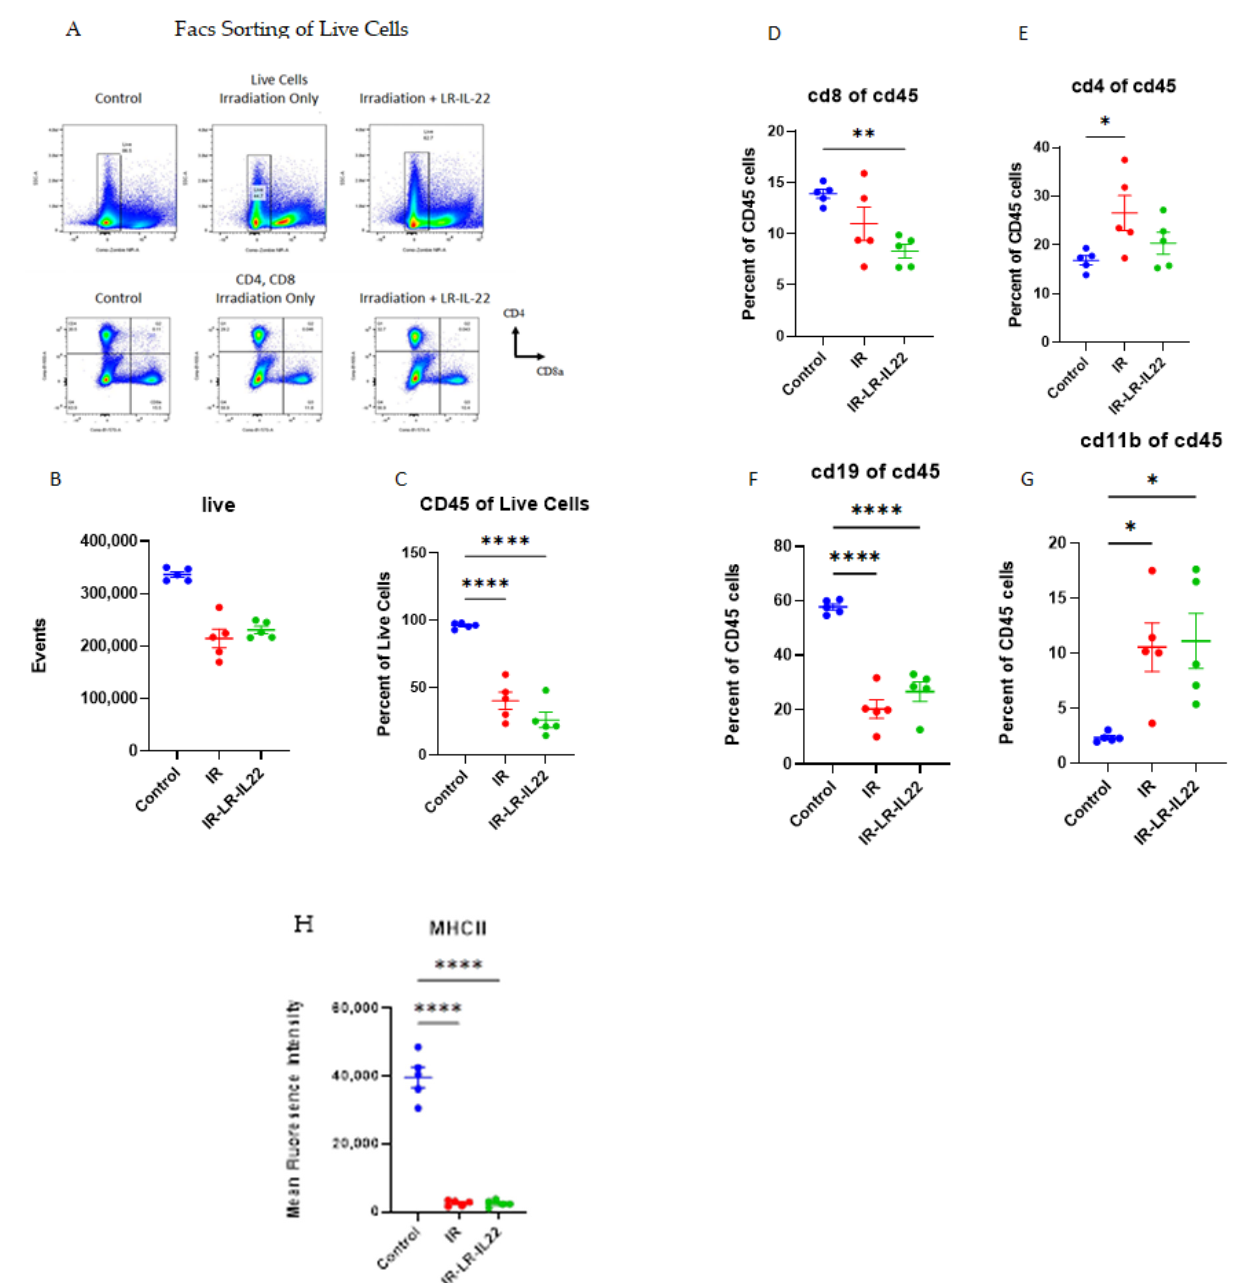
Figure 6. Effect of LR-IL-22 on composition of splenic immunocytes at 21 days after TBI. C57BL/6NTac female mice were irradiated to 8.75 Gy TBI. A subgroup ( n = 5 mice/subgroup) were gavaged with LR-IL-22 at 24 h after irradiation. Twenty-one days following irradiation the mice were euthanized and the spleen was removed, prepared as single cells suspensions, then stained with antibodies to CD45, CD4, CD8, CD19, CD11b, and MHC11 and analyzed by flow cytometry. ( A ) Flow diagrams, ( B ) Number of live cells in the spleen, ( C ) Percent of live cells that are CD45 positive, ( D ) Percent of CD45 cells that are CD8 positive, ( E ) Percent of CD45 cells that are CD4 positive, ( F ) Percent of CD45 cells that are CD19 positive, ( G ) Percent of CD45 cells that are CD11b, and ( H ) Mean Fluoresence Intensity (MFI) for MHCII expression of CD45 positive cells. Results are plotted as mean ± standard error of the mean. * represents p < 0.05, ** represents p < 0.01, **** represents p < 0.0001 compared to the control mice.